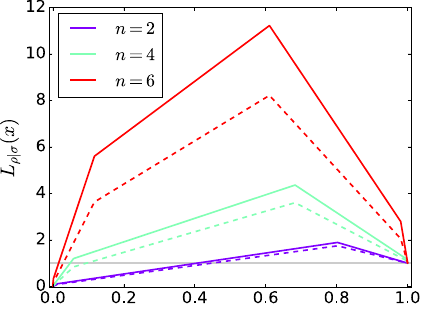
Fig. 3 A “ heretical ” family of Lorenz curves. Traditionally, Lorenz curves for distributions are monotone increasing cumulative functions that reach a maximum value of 1. In contrast, Lorenz curves for magic states break through the value of L ( x ) = 1 due to the presence of negativity in the associated quasi-distributions. The above family of curves correspond to multiple copies of noisy Strange states ρ : = ρ S ( ϵ ) ⊗ n (Eq. 23) for n = 2, 4, 6 within R σ , where σ ¼ 1 = 3 . Solid lines represent pure Strange states, while dashed lines represent ϵ -noisy Strange states with depolarizing error ϵ =